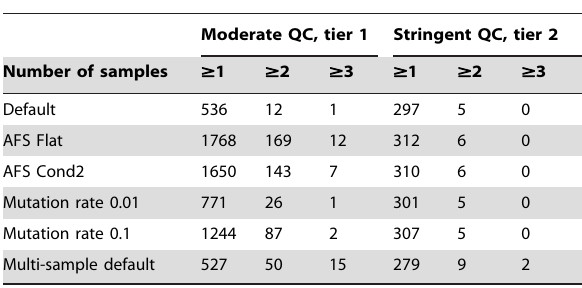
Table 4. Number of genes with novel variants in x or more